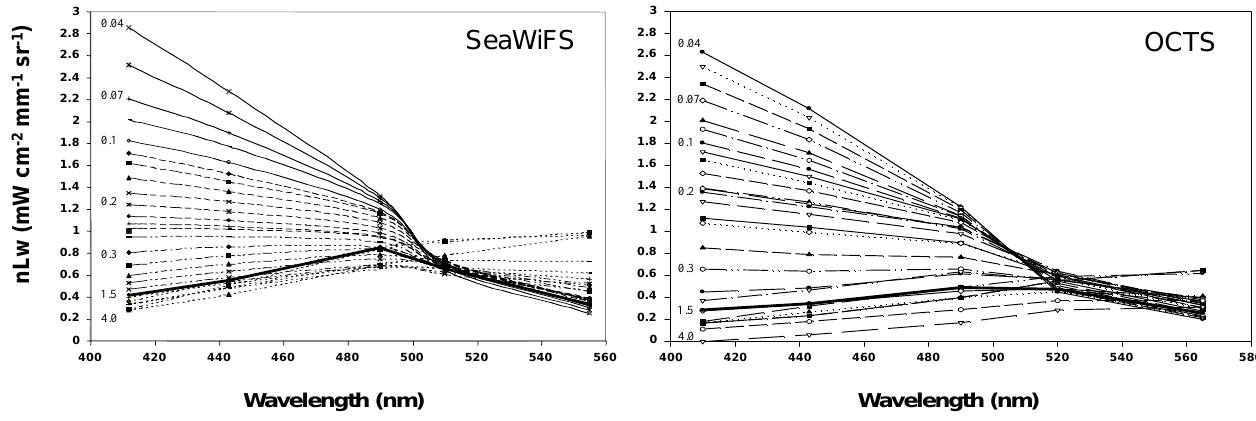
Fig. 1. A comparison between the SeaWiFS (left) and OCTS (right) reference model (nLw ref ) of the normalized water-leaving radiance (nLw) as a function of wavelength for various chlorophyll- a concentrations (Chl- a